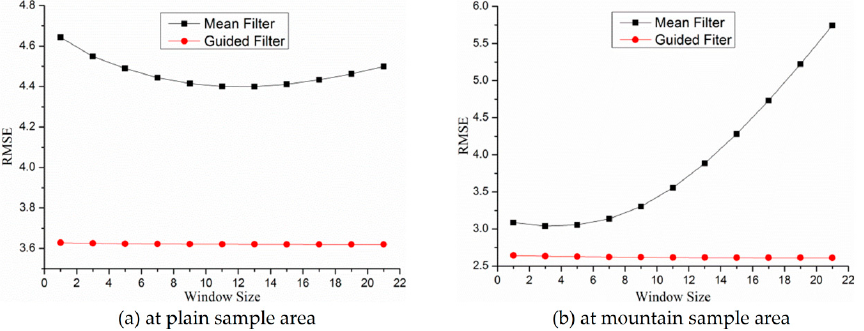
Figure 9. Analysis of the influence of window size on height root mean square error (RMSE) at different sample areas. sample